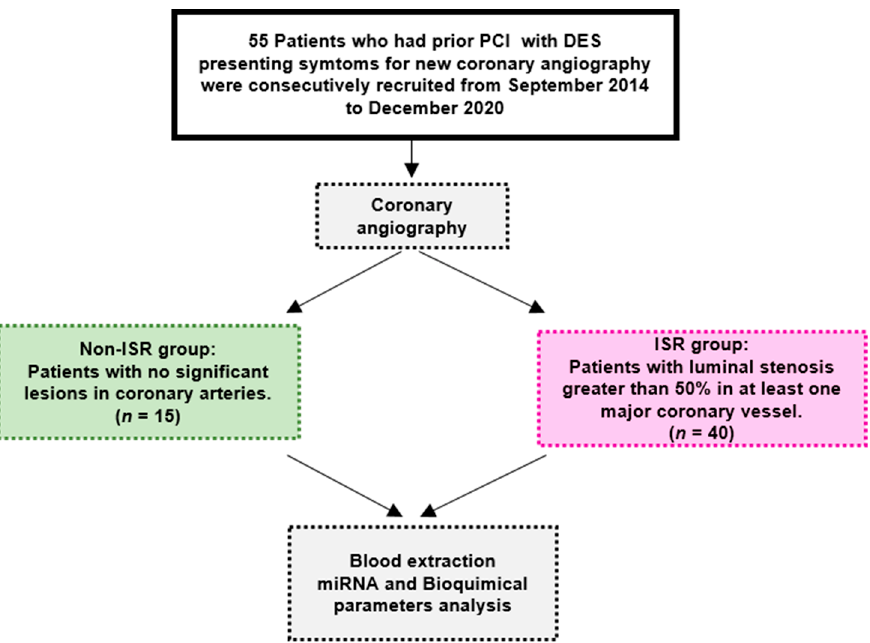
Figure 1. Strengthening the reporting of observational studies in epidemiology (STROBE) diagram of the subjects and the study flow. DES: drug-eluting stent, ISR: patient with in-stent restenosis, non-ISR: patient with non in-stent restenosis, miRNA: microRNA, and PCI: percutaneous coronary interventions,.